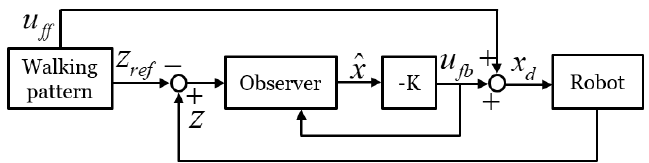
Figure 5. Block diagram of previous ZMP control without capture-point feedback.